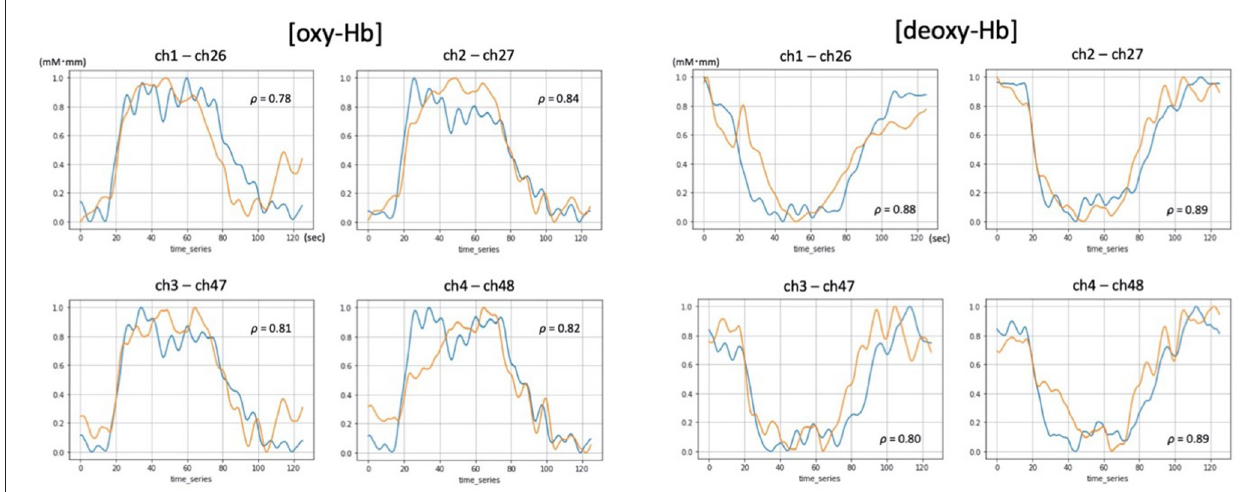
FIGURE 2 | Examples of [oxy-Hb] and [deoxy-Hb] time-courses demonstrating significant and high correlations between 52ch-NIRS and cNIRS ( P -value < 0.00089; correction for multiple comparisons). Blue and orange lines represent time course changes during the verbal fluency task (VFT) detected by 52ch-NIRS and cNIRS, respectively. For each of the four cNIRS and 52ch-NIRS channel pairs (ch1/ch26, ch2/ch27, ch3/ch47, and ch4/ch48), [oxy-Hb] and [deoxy-Hb] exhibited similar activation patterns. Transformed Hb-values (mM mm) ranged from 0 to 1 and are displayed for visualization purposes (the data were transformed using a minimum-maximum scaler, which converted the minimum value to 0 and the maximum value to 1 for each dataset).